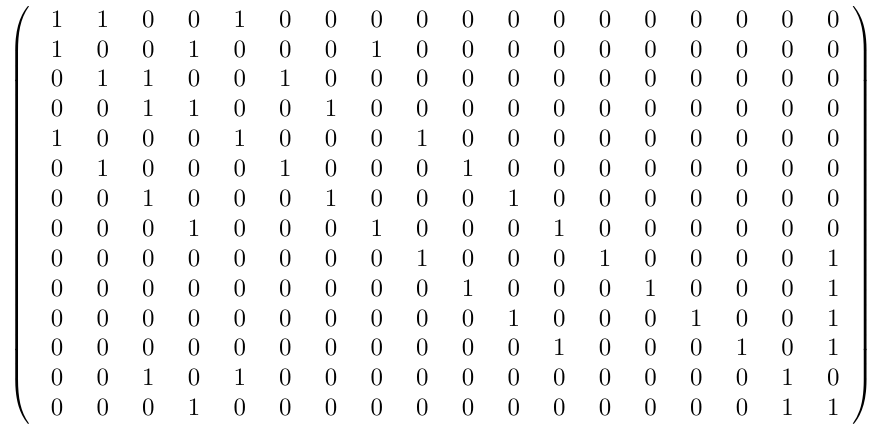
Figure 11: Parity-check matrix of the LDPC code corresponding to Figure